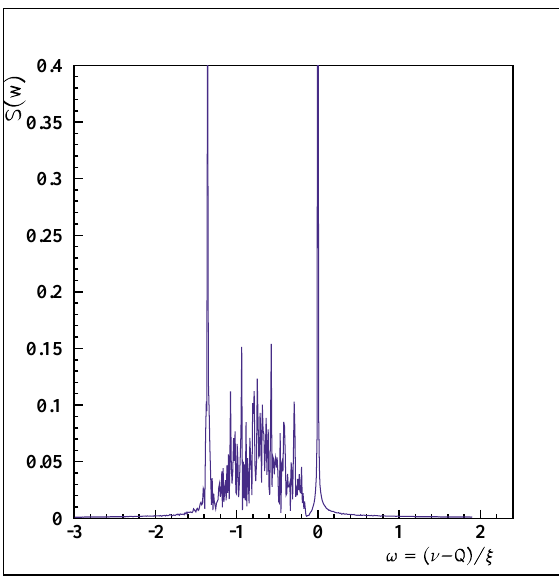
FIG. 6. (Color) Frequency spectrum of the bunch centroid motion (for 2 17 turns, N (cid:1) 10 4 macroparticles) for round beams and size ratios s (cid:2) 2 (cid:3) (cid:5) s (cid:2) 1 (cid:3) of 0.90 (left) and 0.70 (right).